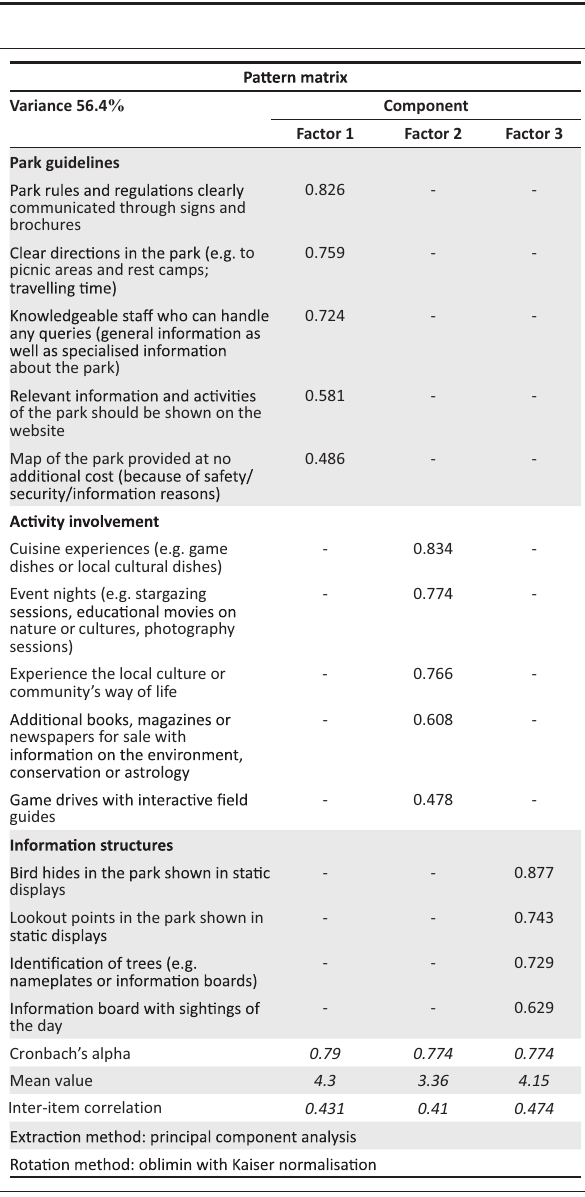
FIGURE 2: Preferred interpretation